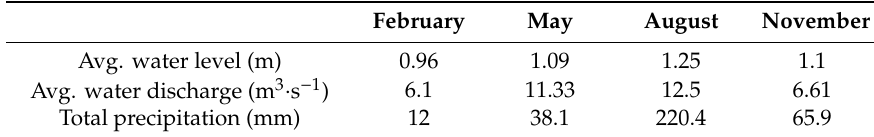
Table 1. Average water level, water discharge, and total precipitation in the Taehwa River estuary in